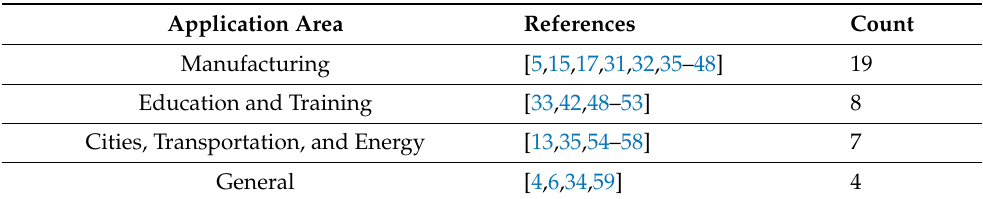
Table 1. Identified literature for the main application areas. Some sources address multiple applica- tion